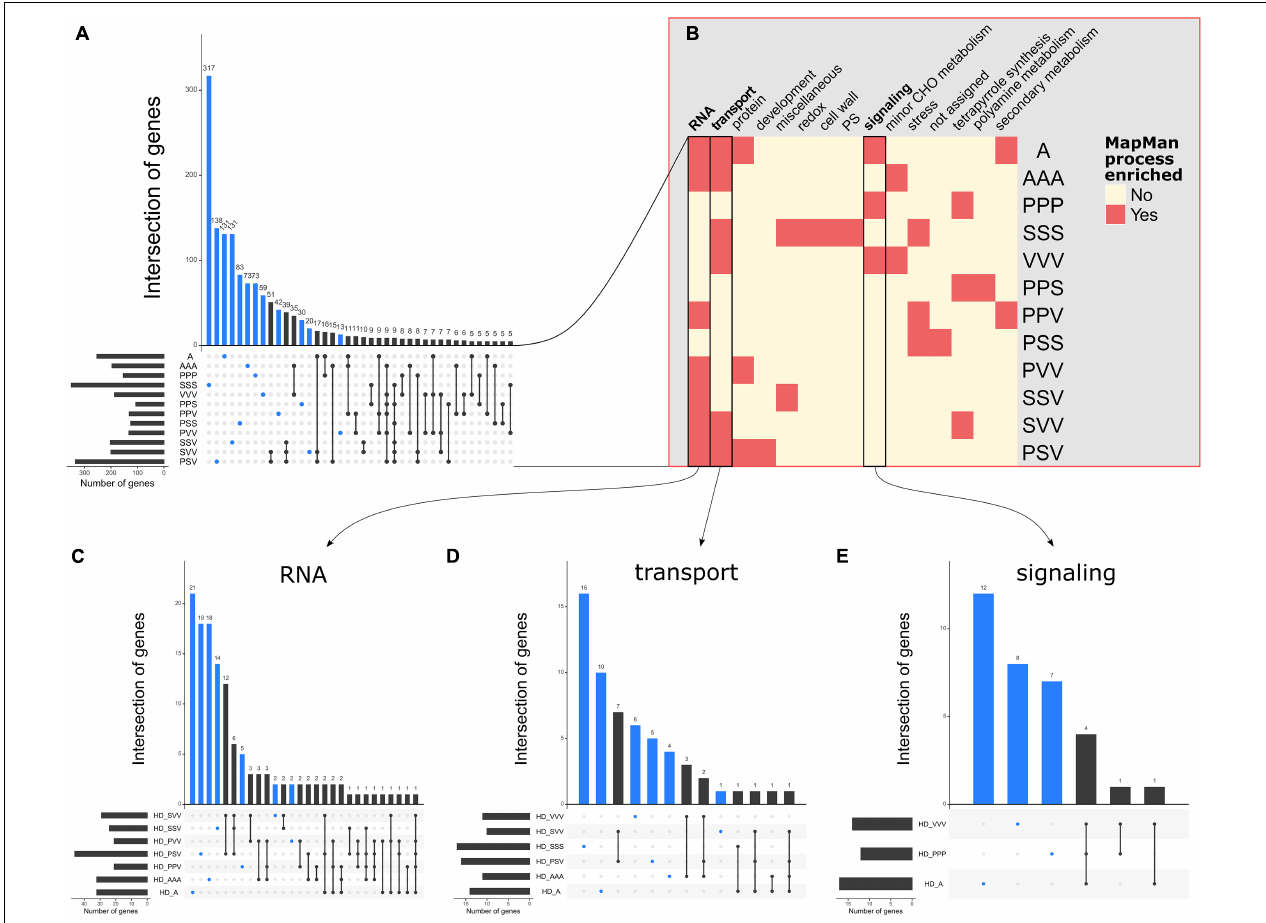
FIGURE 5 | Illustrations of the flexibility of genetic architecture and the processes involved in HD among the 12 treatments. (A) An UpSet plot illustrating the variability of genes underlying the quantitative trait loci (QTLs) related to HD among the 12 treatments. (B) A heatmap illustrating the different MapMan enriched processes among the 12 treatments. (C) An UpSet plot illustrating the variability of genes involved in the RNA process underlying the seven treatments enriched in the RNA process. (D) An UpSet plot illustrating the variability of genes involved in the transport process underlying the six treatments enriched in the transport process. (E) An UpSet plot illustrating the variability of genes involved in the signaling process underlying the three treatments enriched in the signaling process. The blue dots and bar plots highlight the genes that are specific to only one treatment. UpSet plots were drawn with the R package UpSetR (Conway et al.,